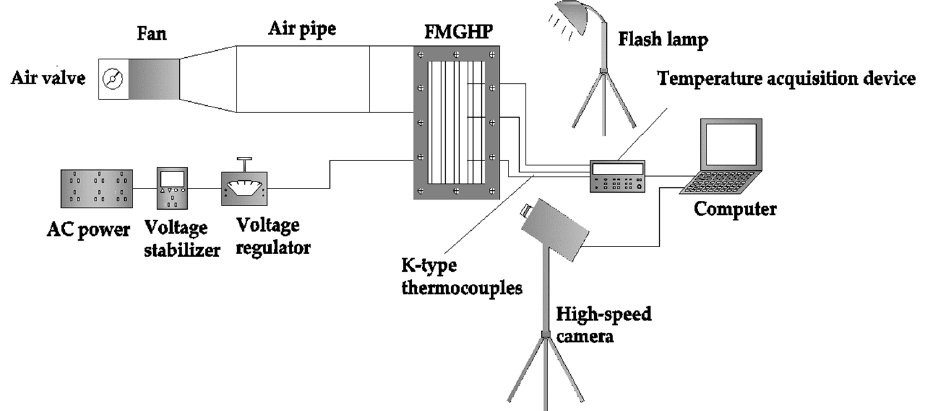
Figure 2. Experimental system of the semi-visualization FMGHP. AC = alternating current.